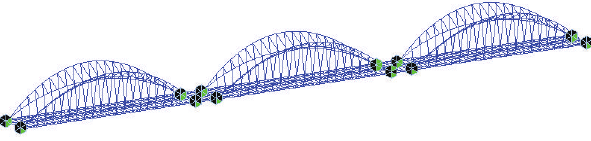
Figure 9: FE model of objective bridge.